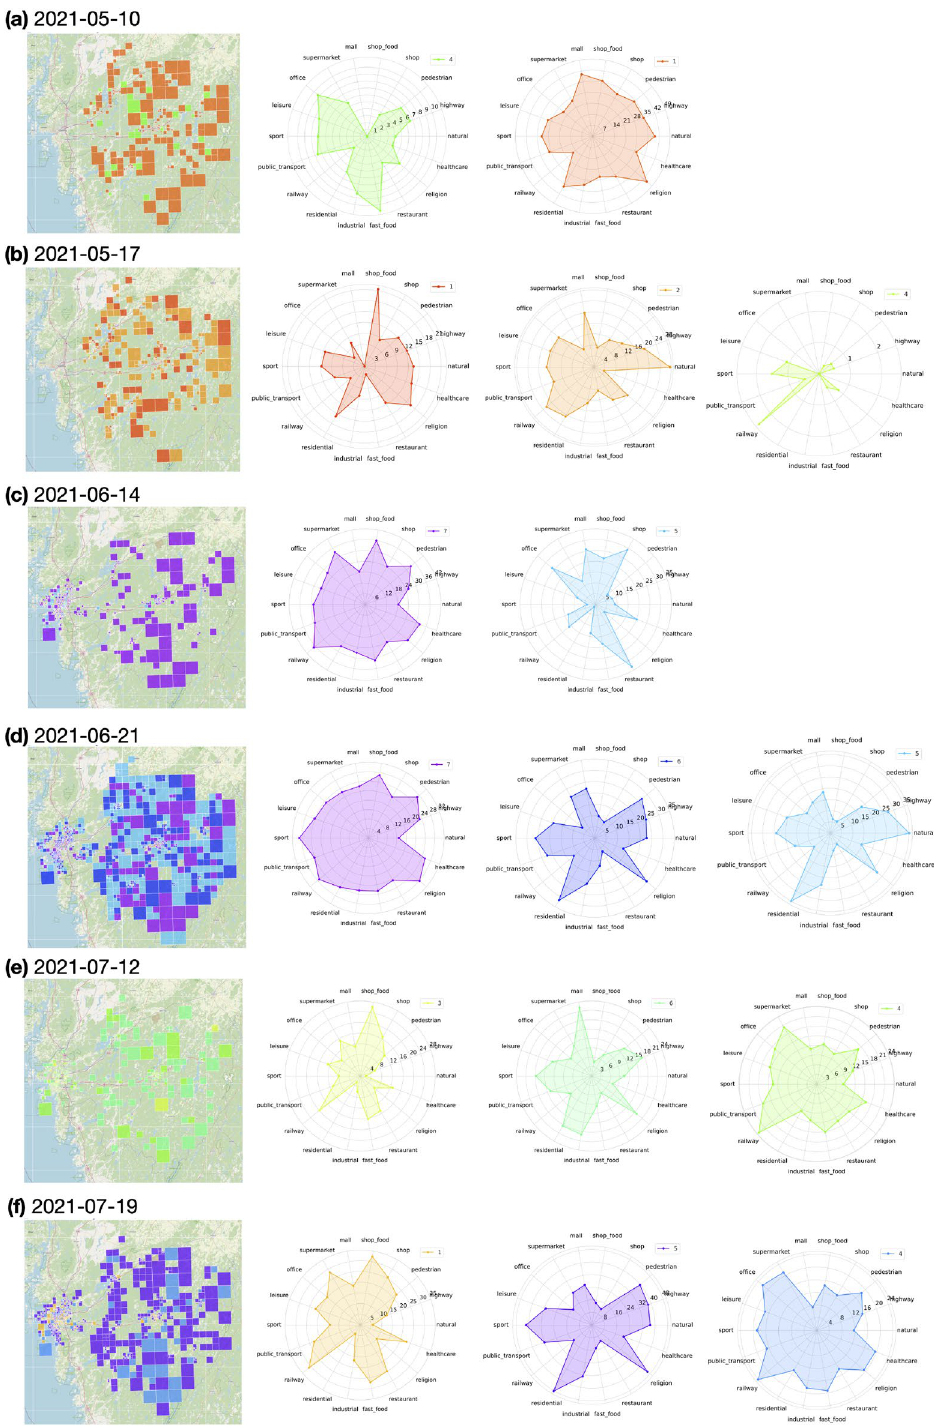
Figure 3. Selected clusters of grids by the grid selection model used in construction of the forecast models for Södra Älvsborgs hospital. ( a – f ) The figure shows the results for selected analysis dates. Note that there is no one- to-one correspondence between the same colors across two arbitrary analysis